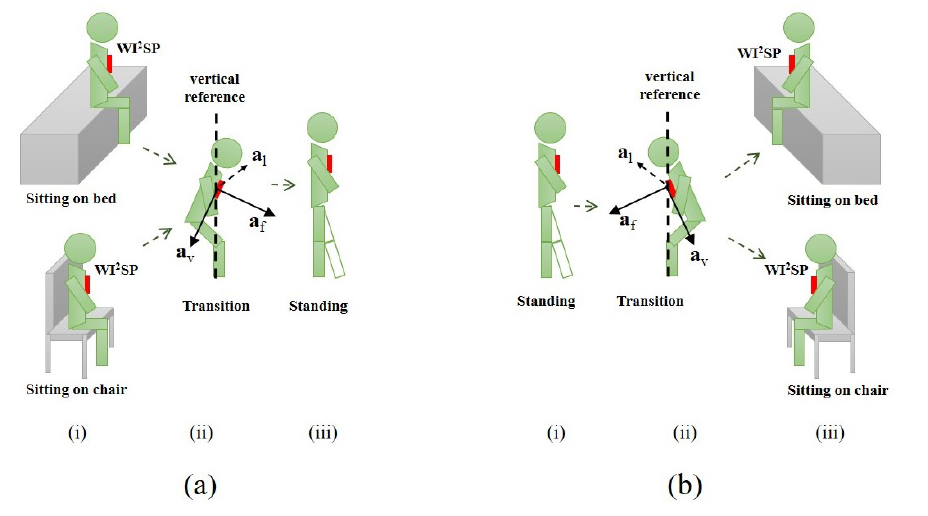
Figure 2. Experimental setting for data collection using W 2 ISP during activities: ( a ) sit-to-stand (Si2St); (i) sitting on the bed/chair, (ii) transition, (iii) standing; ( b ) stand-to-sit (St2Si); (i) standing, (ii) transition, (iii) sitting on the bed/chair.